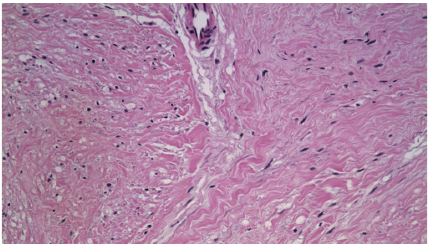
Figure 5: Microscopic pathological findings revealed that the lesion was composed of a spindle cell proliferation that was arranged in interlacing fascicles and formed multiple nodules with a moderate amount of